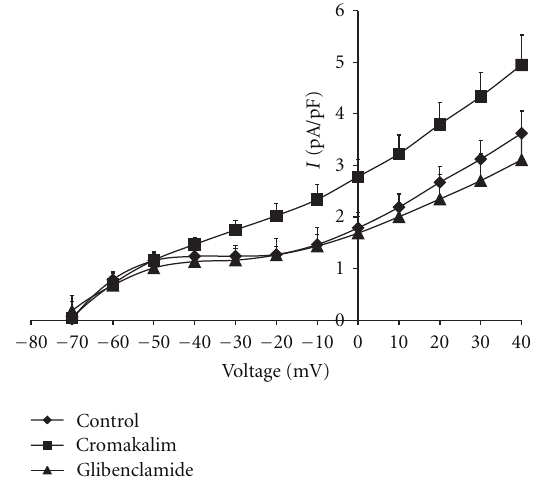
Figure 1: Voltage-Current Relationships in Sham-Operated Con- trol Rats. Sarcolemmal outward potassium current (I), expressed as current density (pA/pF), in patches of ventricular myocytes from adult control rats subjected to a sham surgical operation, treatment with the ATP-sensitive potassium channel (KATP) agonist cro- makalim (100 μ M), and post-treatment with the KATP antagonist glibenclamide (5 μ M). The membrane voltage was clamped at steps of 10 mV from − 80 mV to +40 mV. Di ff erences in pA/pF in the presence and absence of treatment with cromakalim, and post- treatment with glibenclamide were significant only at the voltages from − 20mV to +40mV ( P < 0 . 05).